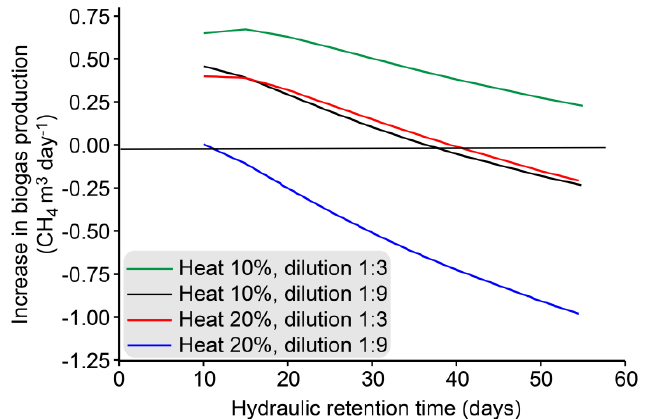
Figure 5. Average net increase in biogas delivered to the household if 20% or 10% of the biogas produced is used to heat the biogas digester to 35 °C (manure from 16